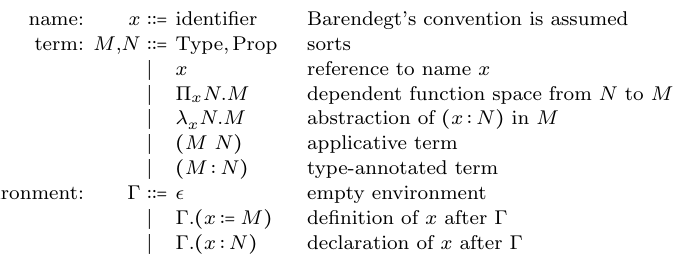
Fig. 11. The abstract syntax of the refined Calculus of